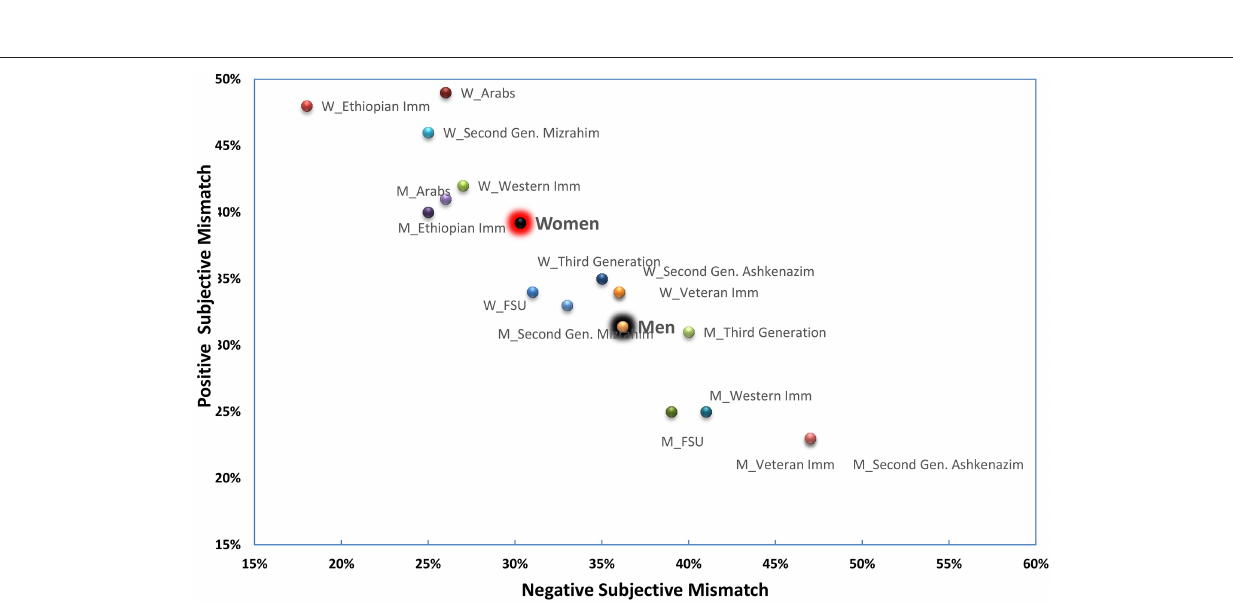
FIGURE 3 | Positive and negative subjective mismatches across different groups. W, Women; M, Men; Imm., immigrants; Miz., Mizrahim; Ashk., Ashkenazim. For example, M_Second Gen. Ashkenazim, Men Second Generation of Ashkenazim.